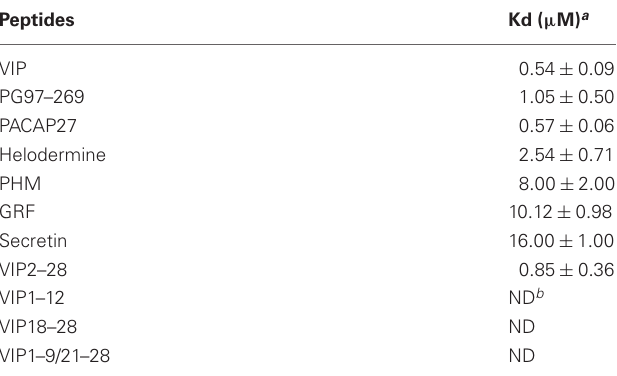
Table 3 | Binding of VIP related-peptides to recombinant